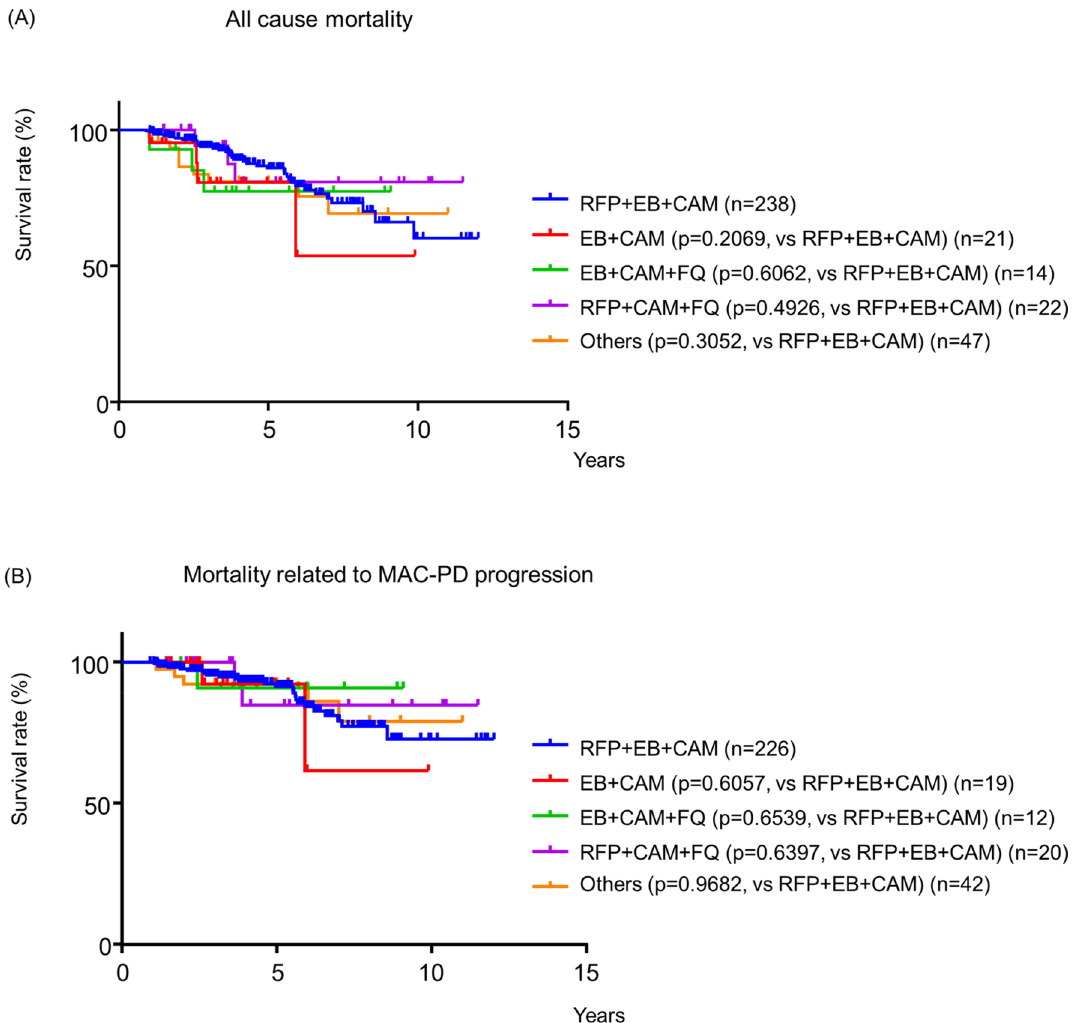
Figure 2. Survival curves for different 1st line combination regimen. ( A ) All cause mortality, ( B ) Mortality from MAC-PD progression. Survival curves were analyzed by log rank